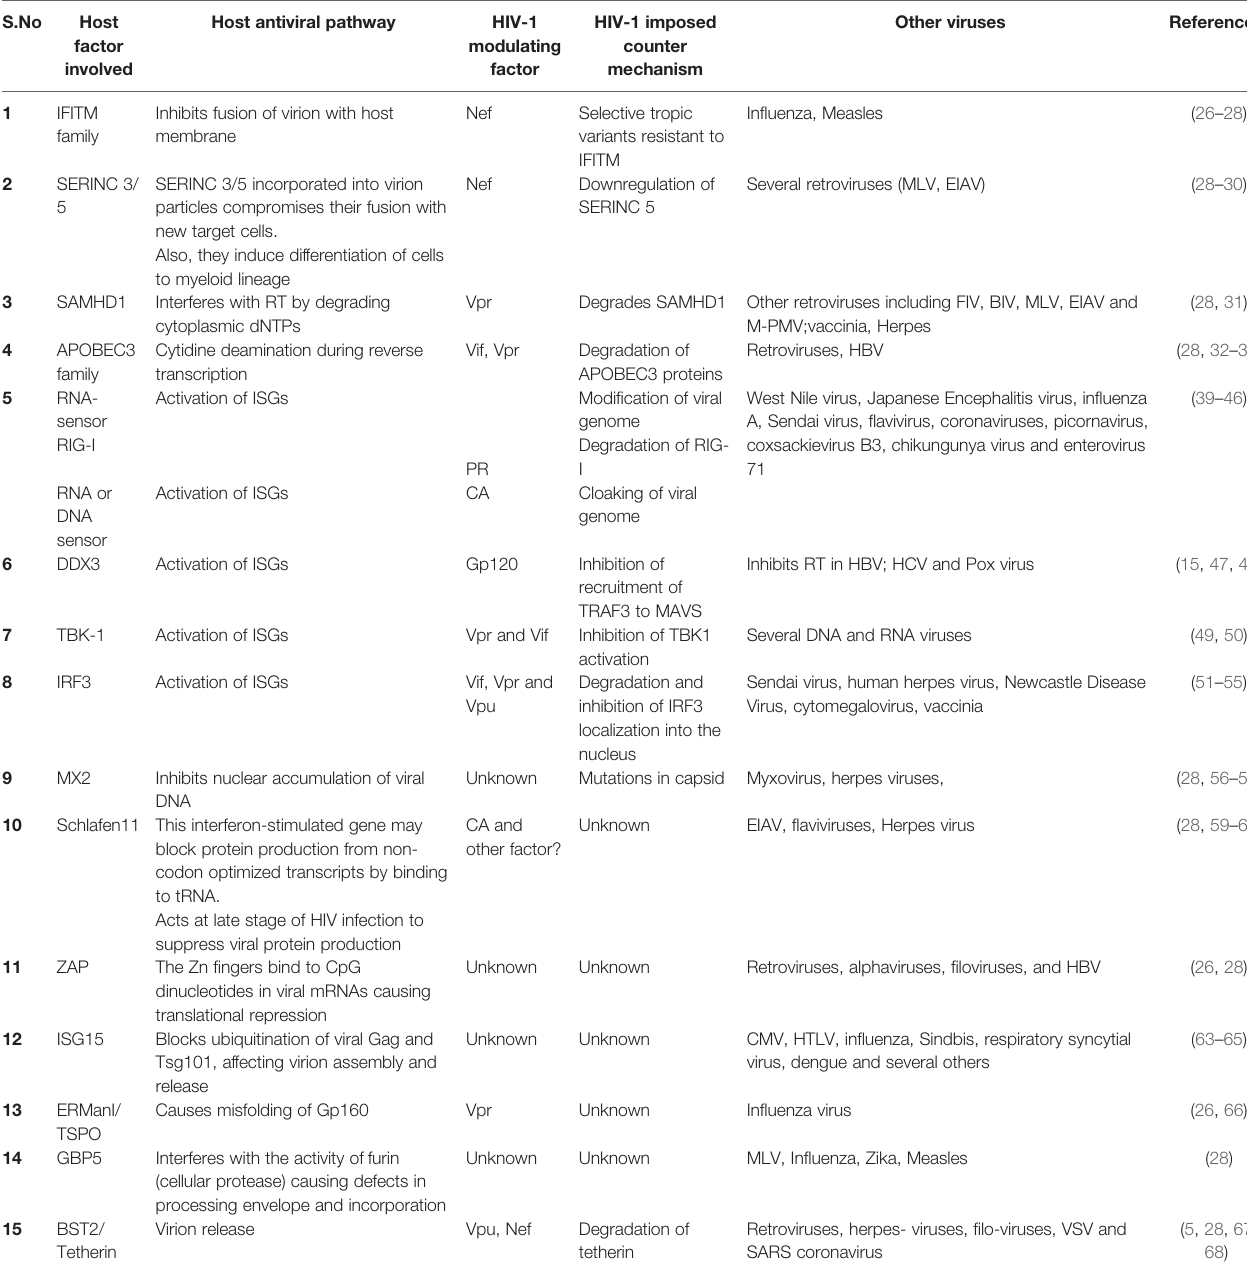
TABLE 1 | The antiviral host defense mechanisms and HIV-1 counteractive measures in infected host cells.